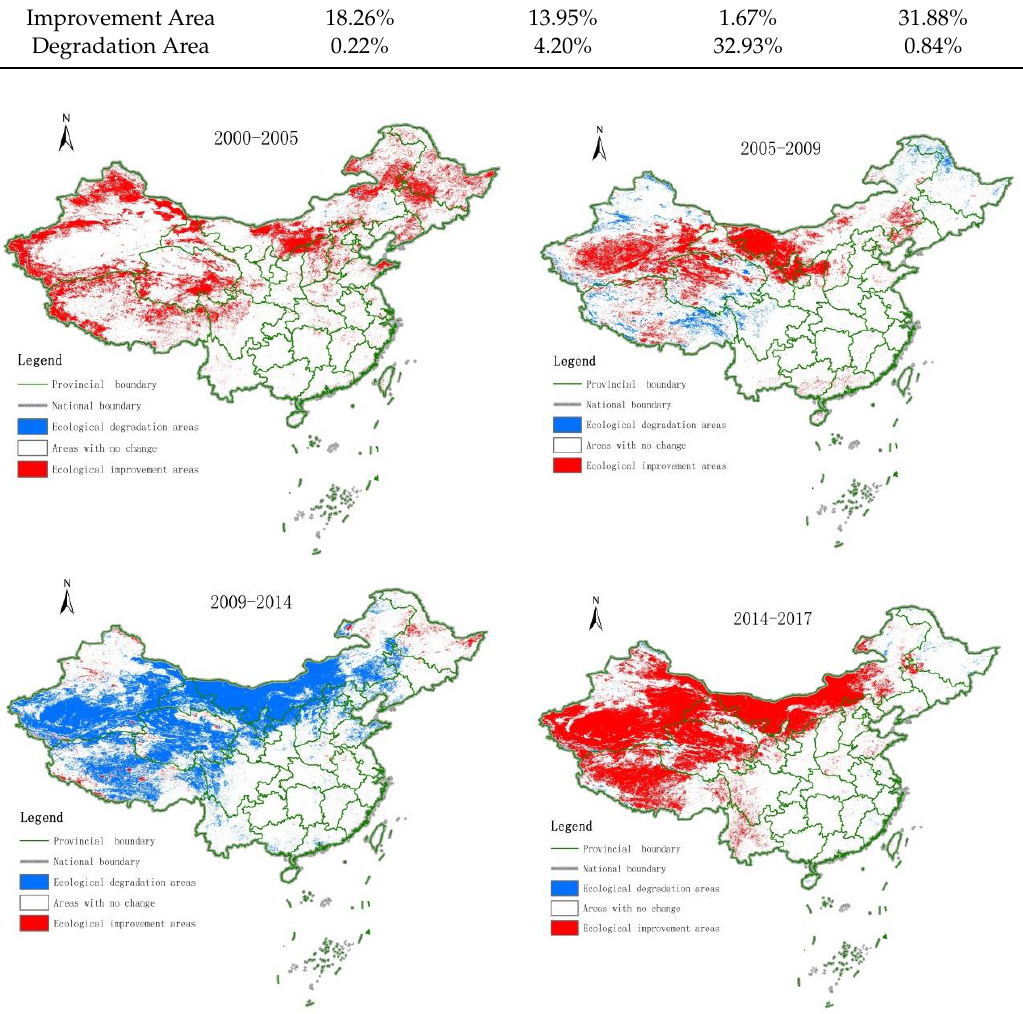
Table 4. Percentage of ecological change in the regions of China in 2000–2017.